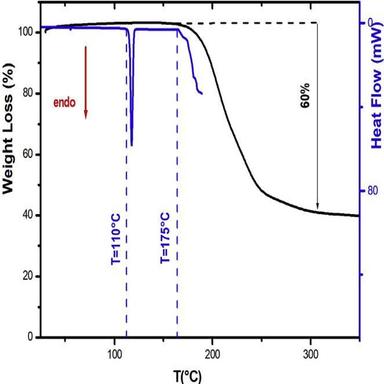
Thermogravimetric analysis/differential scanning calorimetry curves of tetrakis(thiourea)cobalt chloride crystal.